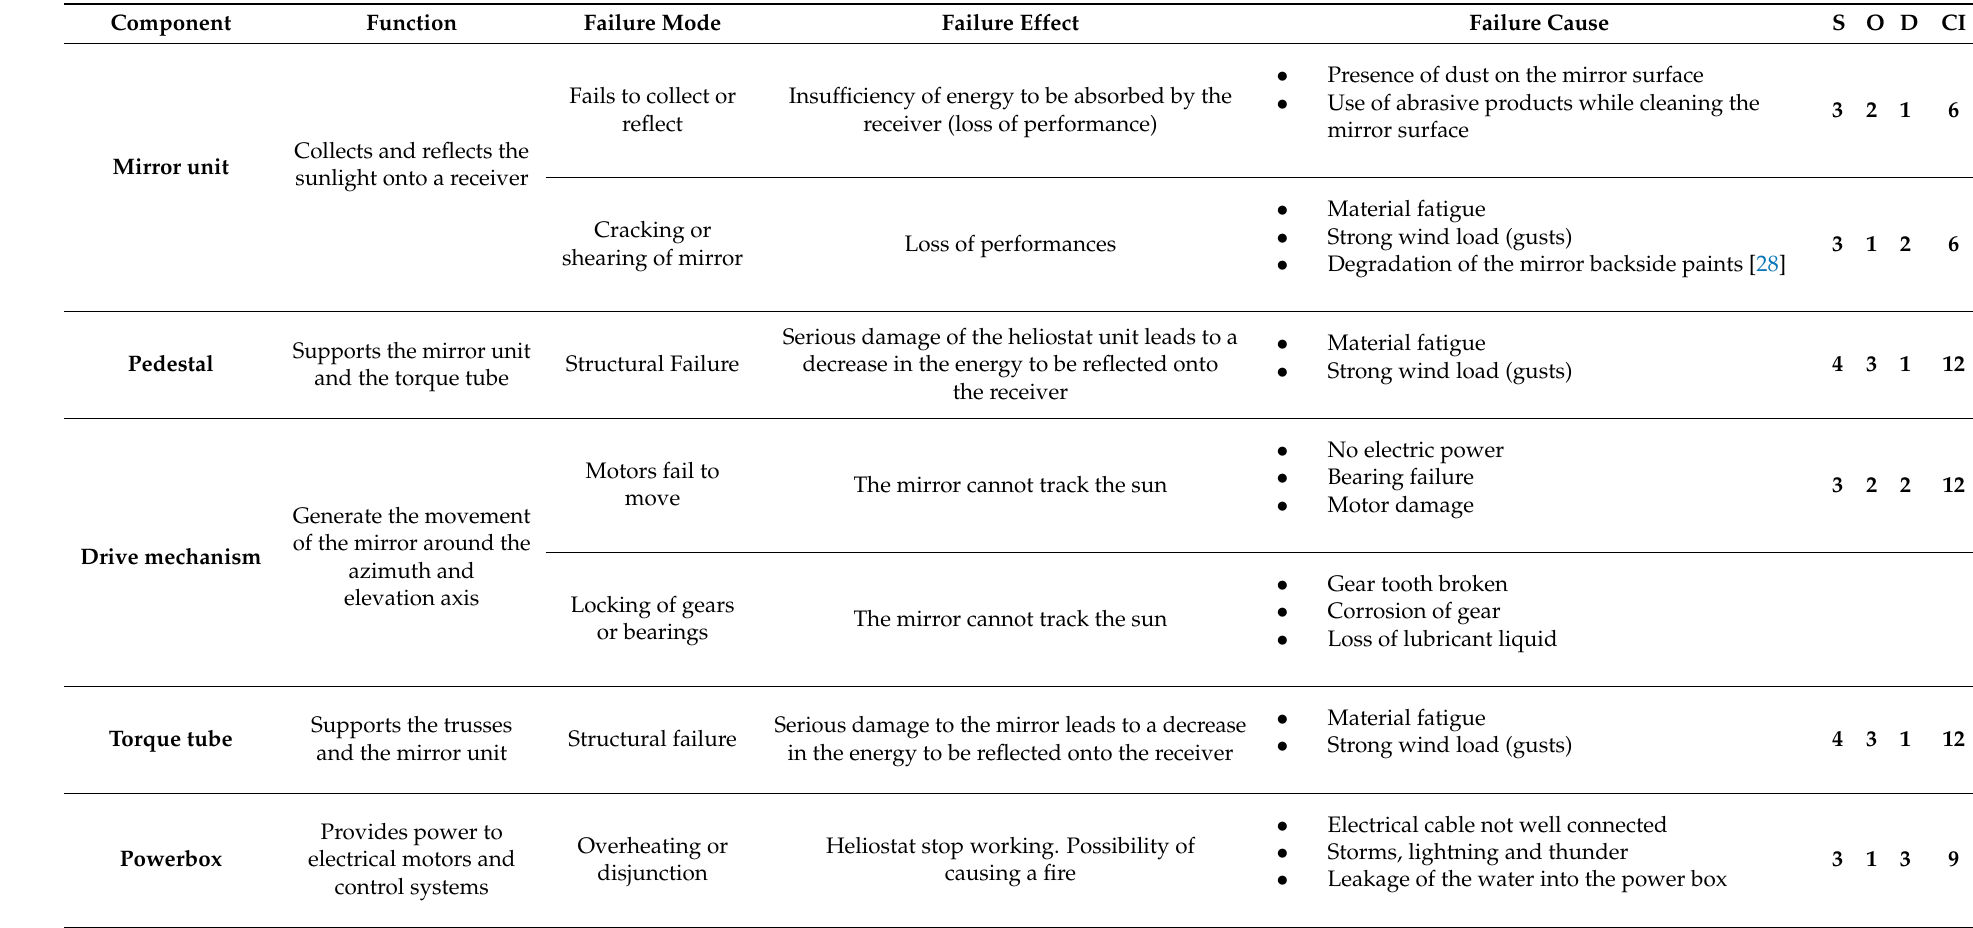
Table 6. Collector subsystem